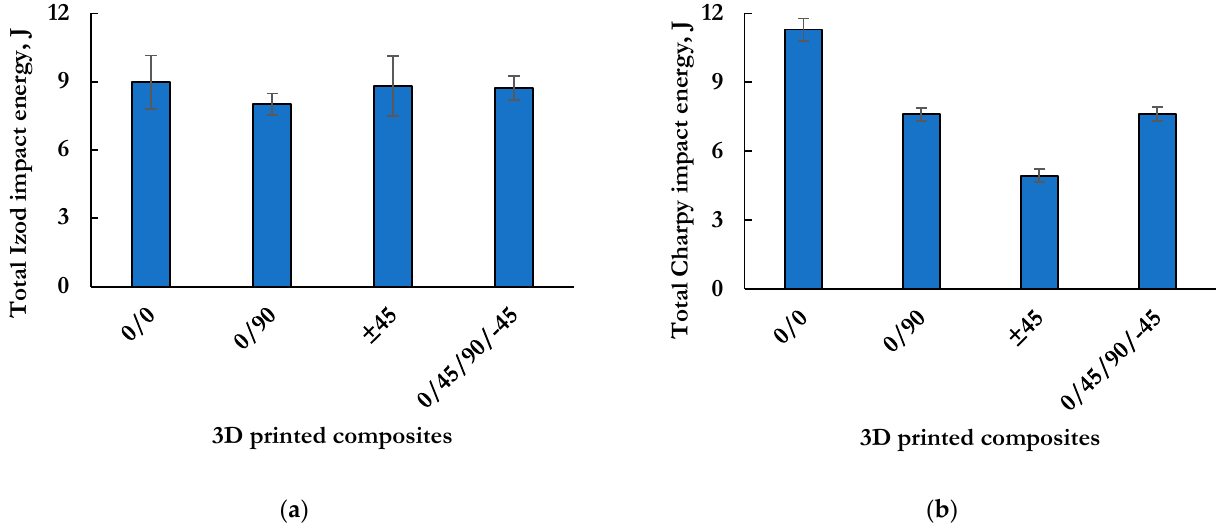
Figure 7. Pendulum impact properties of the printed composites: ( a ) Izod impact energy and ( b ) Charpy impact energy.